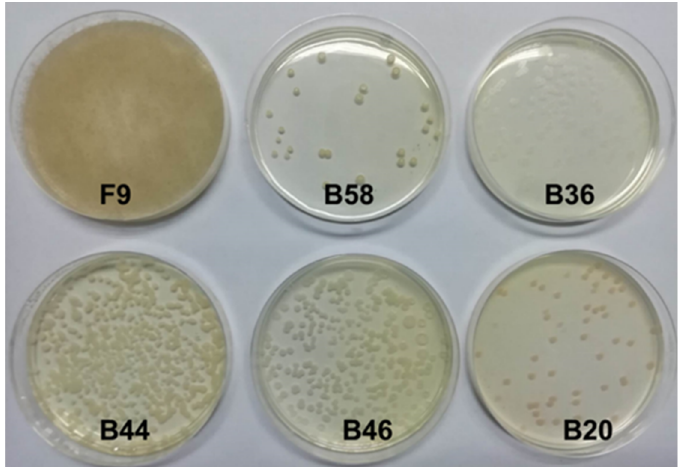
Figure 5. Colonies with lignin degradation potential screened from buffalo rumen. Notes: F9, B20, B36, B44, B46 and B58 mean the numbering of six strains. “F” and “B” on the strain samples originate from fungal and bacterial initials, and the numbers on the strain samples represent the numbering of retained strains with lignin degradation capacity.